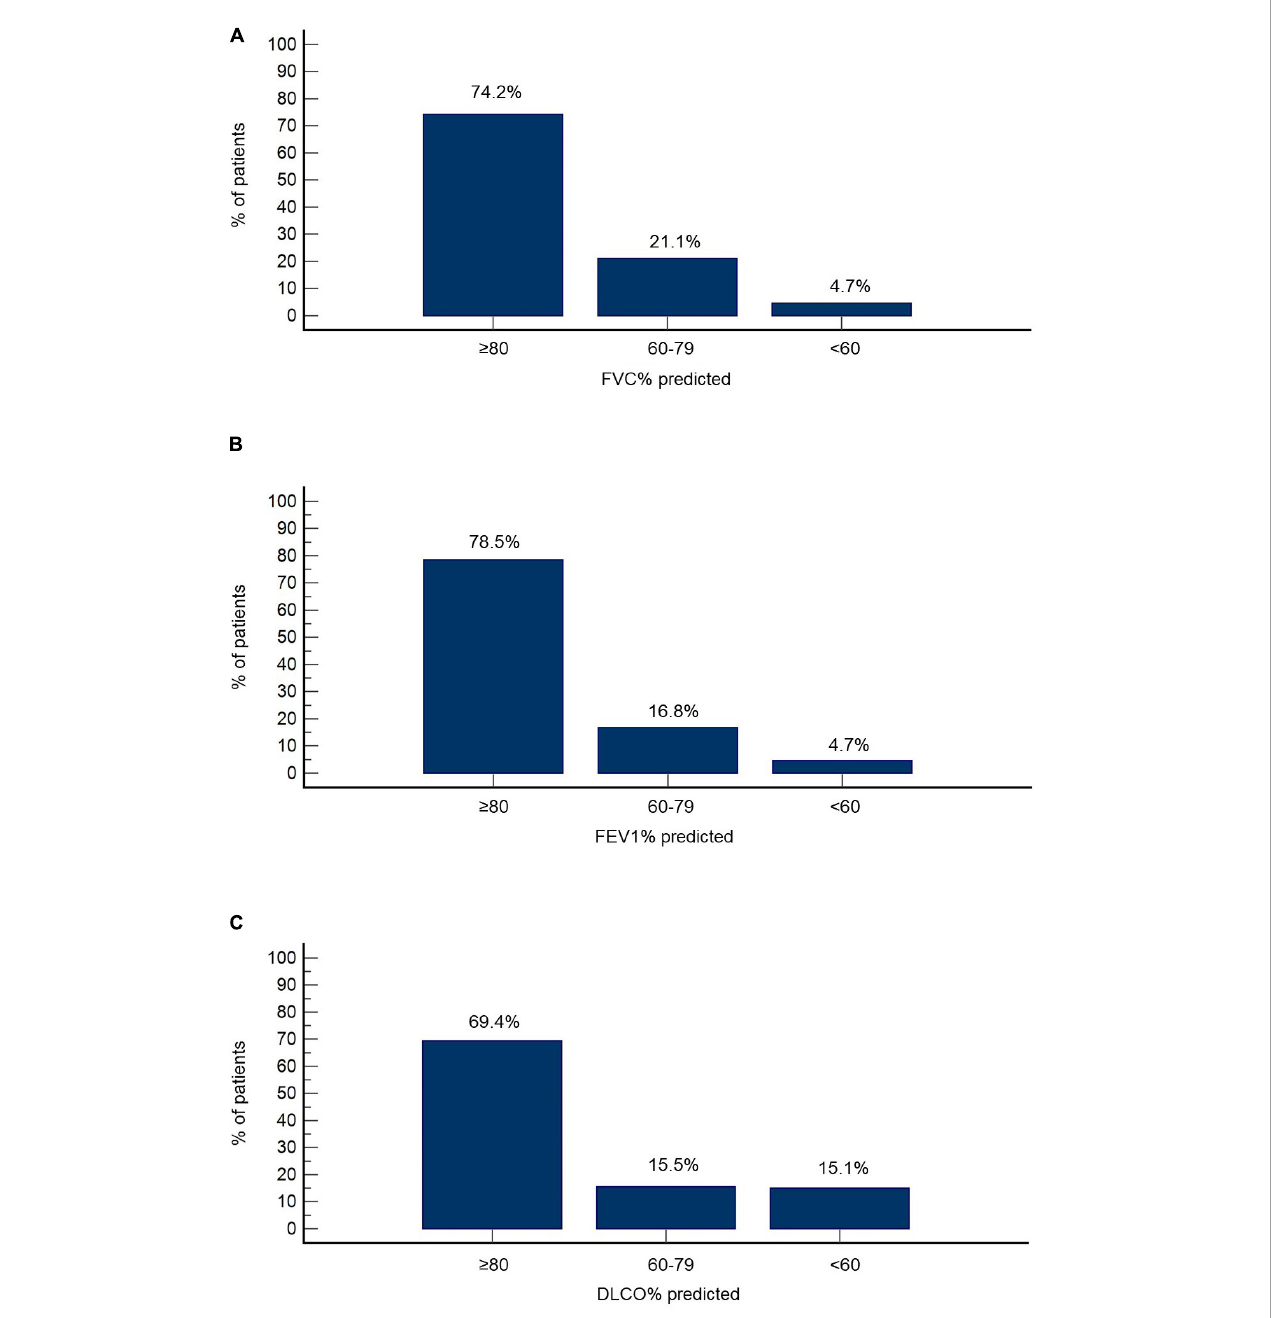
FIGURE1 Functional features at the 3-month follow-up. Percentage of patients with reduced FVC% predicted (A) , FEV1% predicted (B) , and DLCO% predicted (C) is presented.